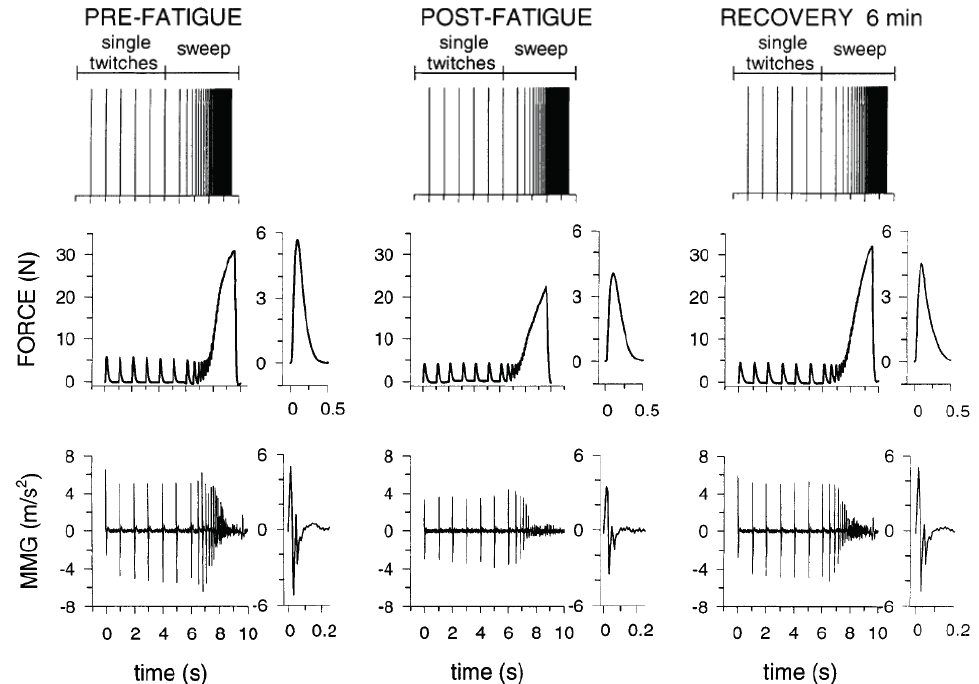
Figure 4. The relationship between the stimuli evoked human tibialis anterior muscle’s mechanical changes during pre fatigue, post fatigue, recovery state and MMG-PTP amplitude. Stimulation pattern (six single twitches and the 1–50 Hz sweep), the force, and MMG responses from top down respectively. A pattern of relation is visibly evident (redrawn from Orizio et al. ,